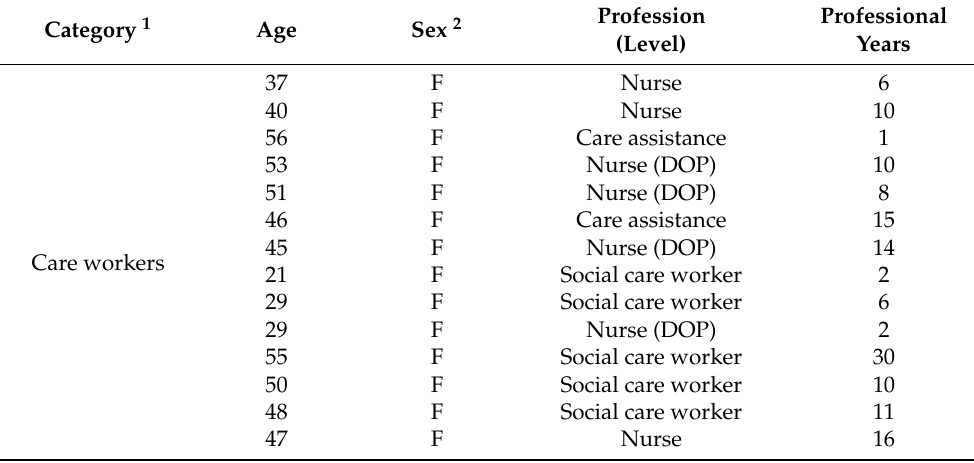
Table 2. Sample description: care workers and